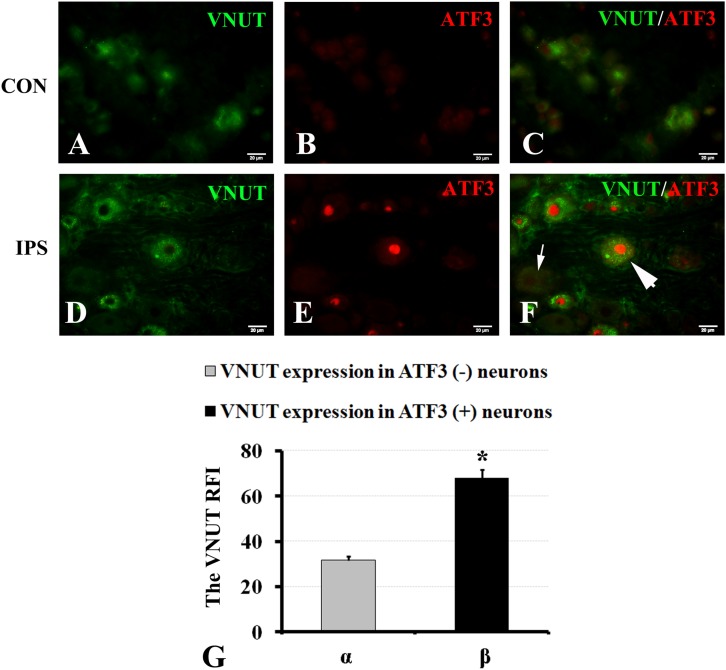
Upregulation of VNUT expression in injured neurons. At 7 days after right sciatic nerve crush, double labeling of VNUT and ATF3 was performed in DRG sections. (A–C) Contralateral DRG images, (D–F) ipsilateral DRG images following sciatic nerve crush. Panels (B,E) immunofluorescence staining for ATF3 (red); Panels (C,F) merged images of panels (A,B) or (D,E), respectively. A thick arrow indicates ATF3-positive neurons, and a thin arrow indicates ATF3-negative neurons; scale bar = 20 μm. (G) Summary histograms depicting the changes in VNUT expression in ATF3-positive neurons and ATF3-negative neurons on the crush side with the paired t-test, α and β, ∗
P < 0.001; bars represent the standard error of the mean; RFI, relative fluorescence intensity.